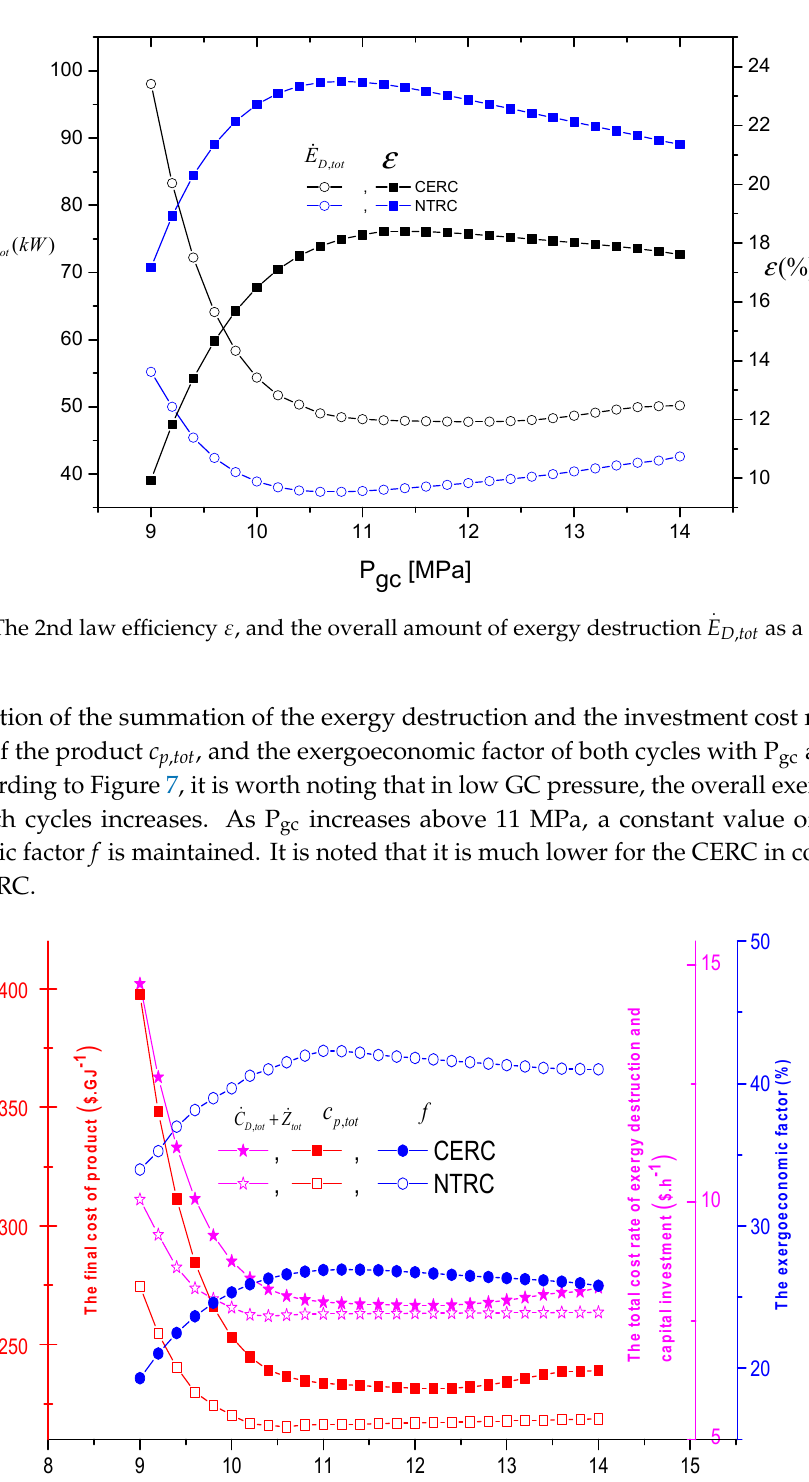
Figure 7. The exergoeconomic factor, the final cost of the product c p , tot , and the overall (cid:1852)(cid:4662) +(cid:1829)(cid:4662) (cid:3005) as functions of P gc.